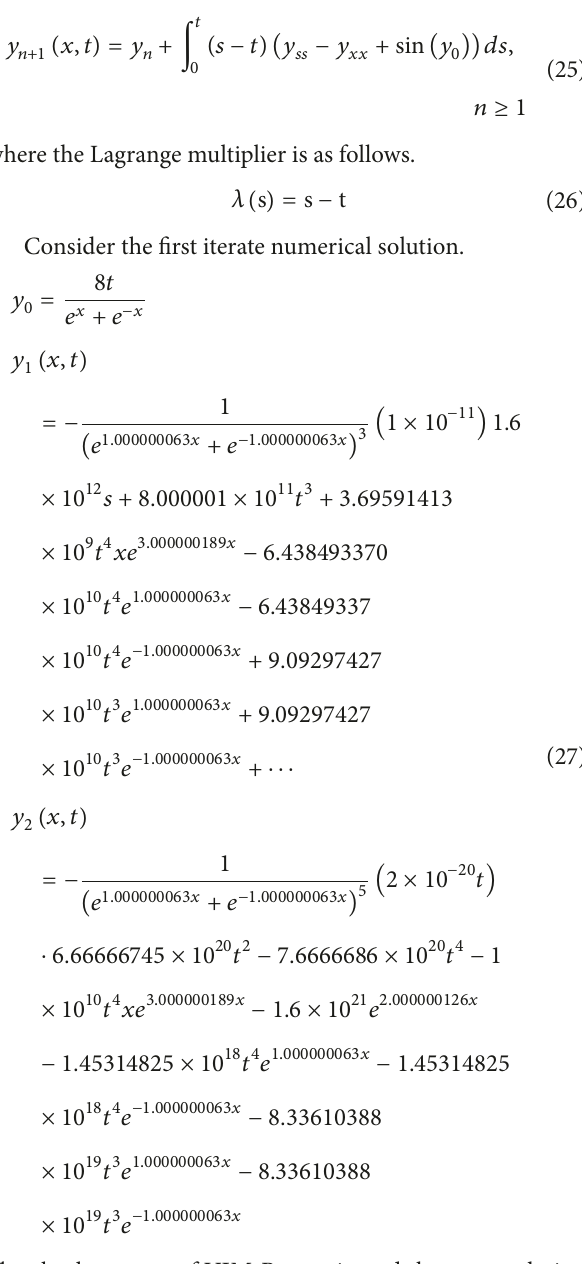
Table 1: The absolute and mean square errors using y 2 for Sine- Gordon equation when n=m=2 and 𝑡 = 0.1 .